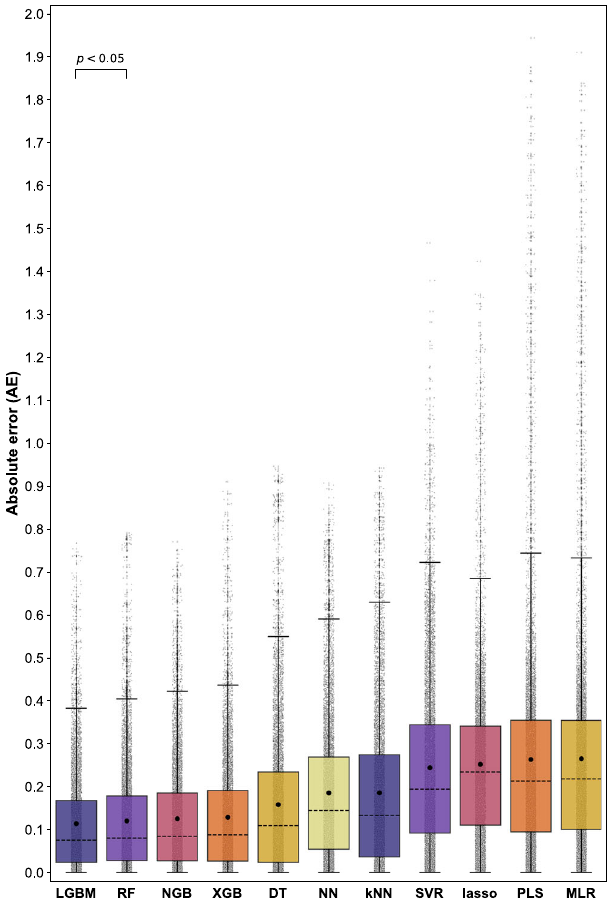
Fig. 2 | Summary of the overall predictive performance of the various ML models represented as a box and whisker plot. The data represent the absolute error (AE) obtained for fractional drug release predictions during nested cross- validation (i.e., n =10 trials). Each column represents the AE value for 8013 data instances from the collective nested cross-validation test sets (light gray circles). Themeanabsoluteerror(MAE)andmedianAEvaluesforeachmodelaredisplayed within the boxes as closed black circles, and black dashed lines, respectively. The fi rstandsecondquartilesareshownbytheupperandloweredgesoftherespective boxes. The whiskers extend to show the rest of the distribution, excluding points determined to be “ outliers ” using the interquartile range method. Source data are provided as a Source Data fi